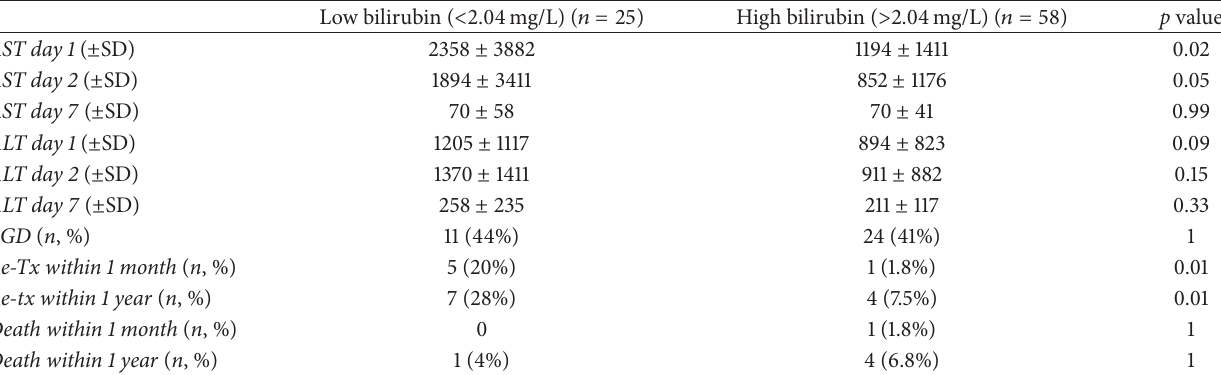
Table 2: An overview of liver biochemistry (transaminase leak as surrogate marker for the reperfusion injury) as well as the early and late transplant outcome in recipients receiving livers from high risk donors (DRI ≥ 2, n = 83).